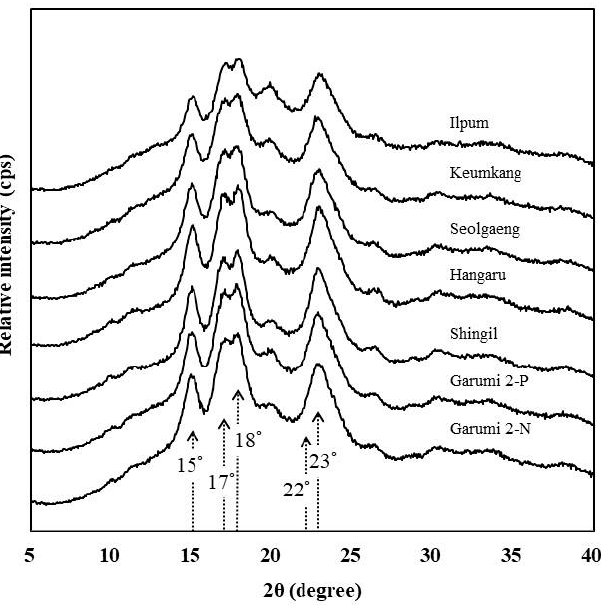
Figure 3. X-ray diffraction (XRD) patterns of starches in six rice varieties and one wheat variety for flour.